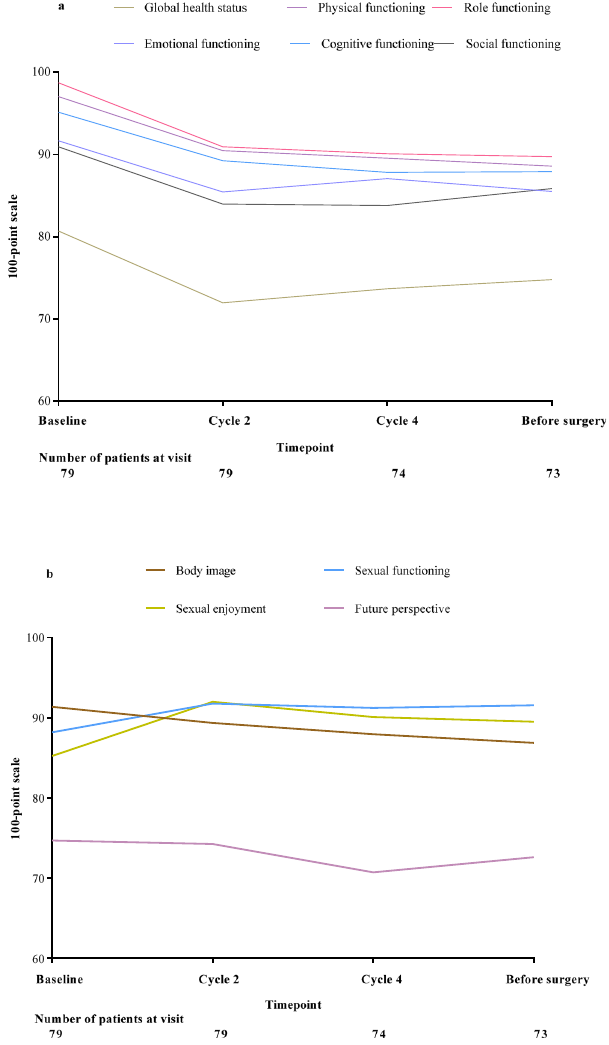
Fig. 4 | Results of health-relatedqualityoflifequestionnaires in QLQ-C30 over time.a Meanscores ofglobalhealth status and functioning subscalesinQLQ-C30. b Mean scores of functioning subscales in QLQ-BR23. QLQ-C30 quality of life questionnaire-core module, QLQ-BR23 quality of life questionnaire-breast cancer module. Source data are provided as a Source Data fi